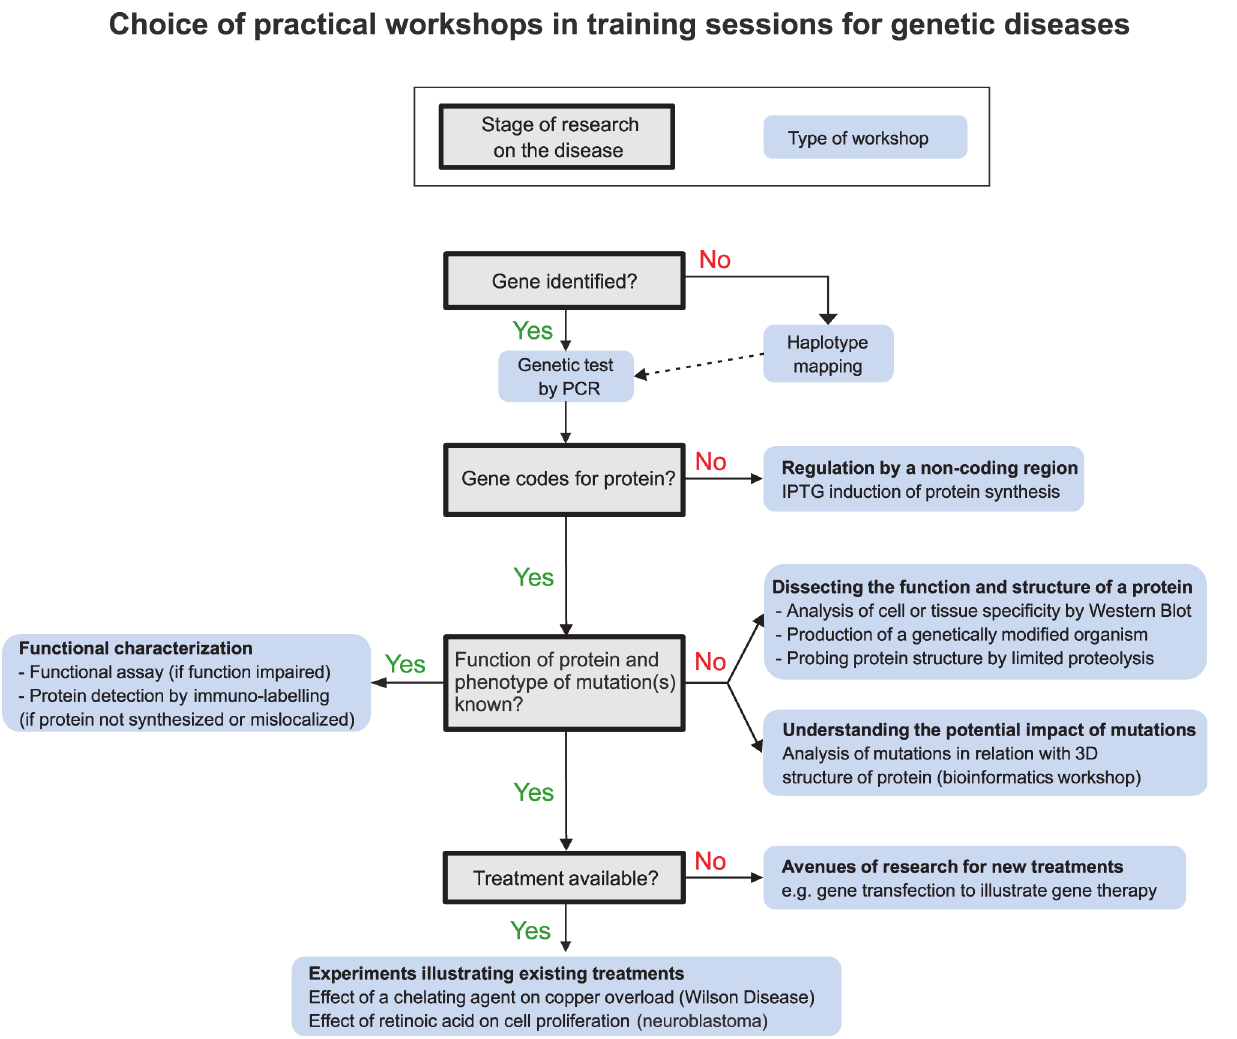
Fig 2. How we tailor practical workshops for a given disease based on the stage of